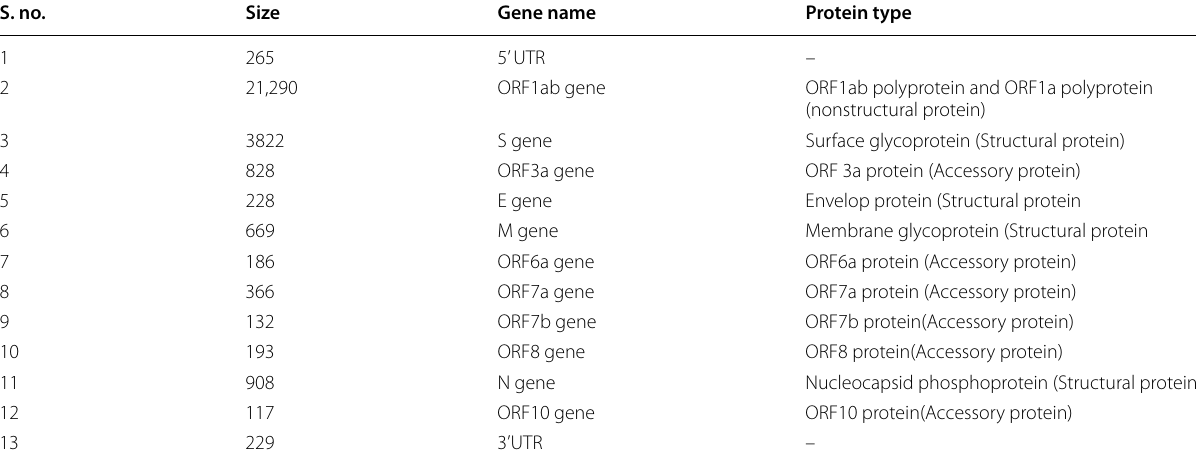
Table 1 Major genes present in the genome of SARS-CoV-2 till data S.